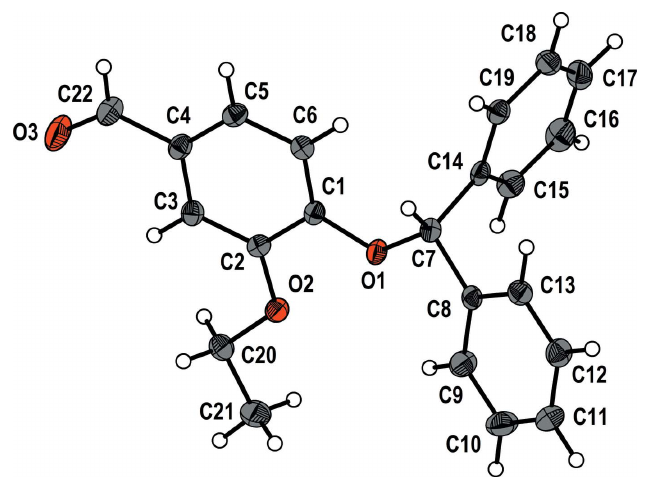
Figure 1 The molecular structure of the title compound with displacement ellipsoids drawn at the 50% probability level.